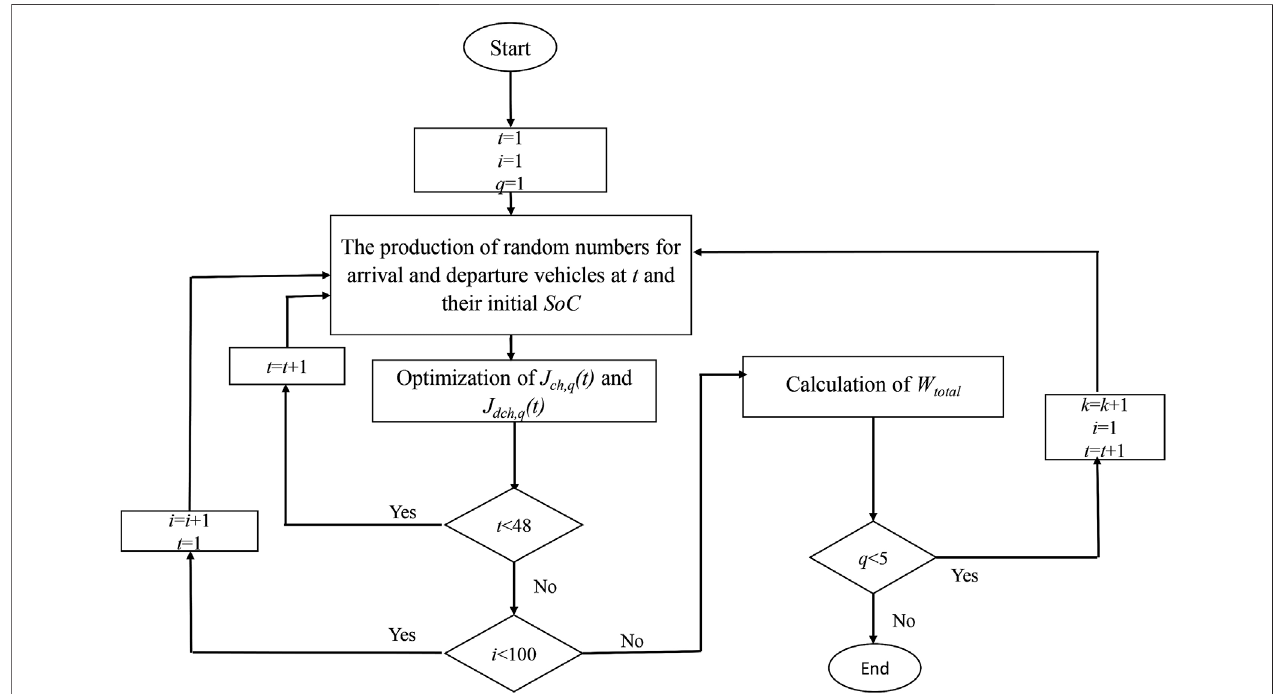
FIGURE 1 | Flowchart of calculating the parking pro fi t of the smart distribution system.